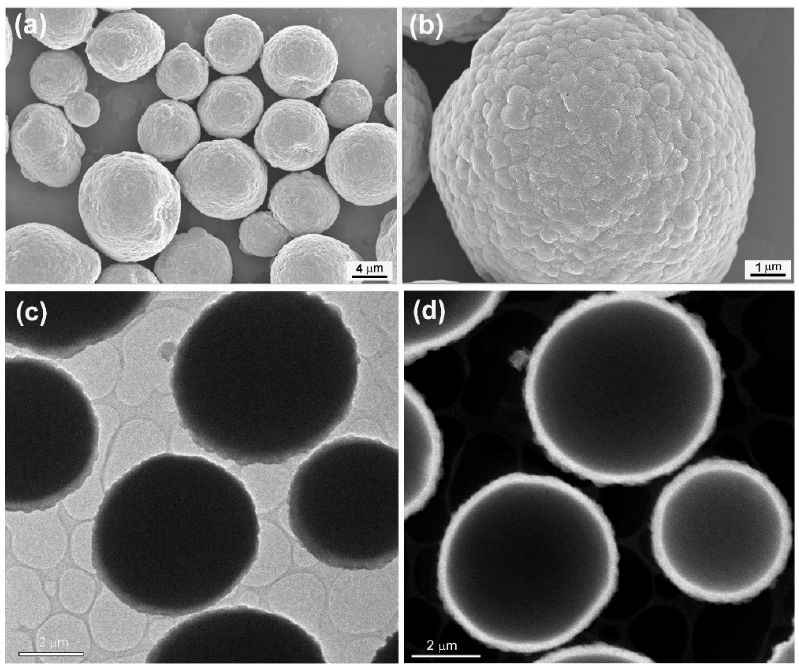
Figure 2. SEM, TEM, and STEM images of SiO 2 -encapsulated SnZn 0.04 Cu 0.015 microspheres via an interface-confined sol–gel method: ( a , b ) SEM, ( c ) TEM, and ( d ) STEM.